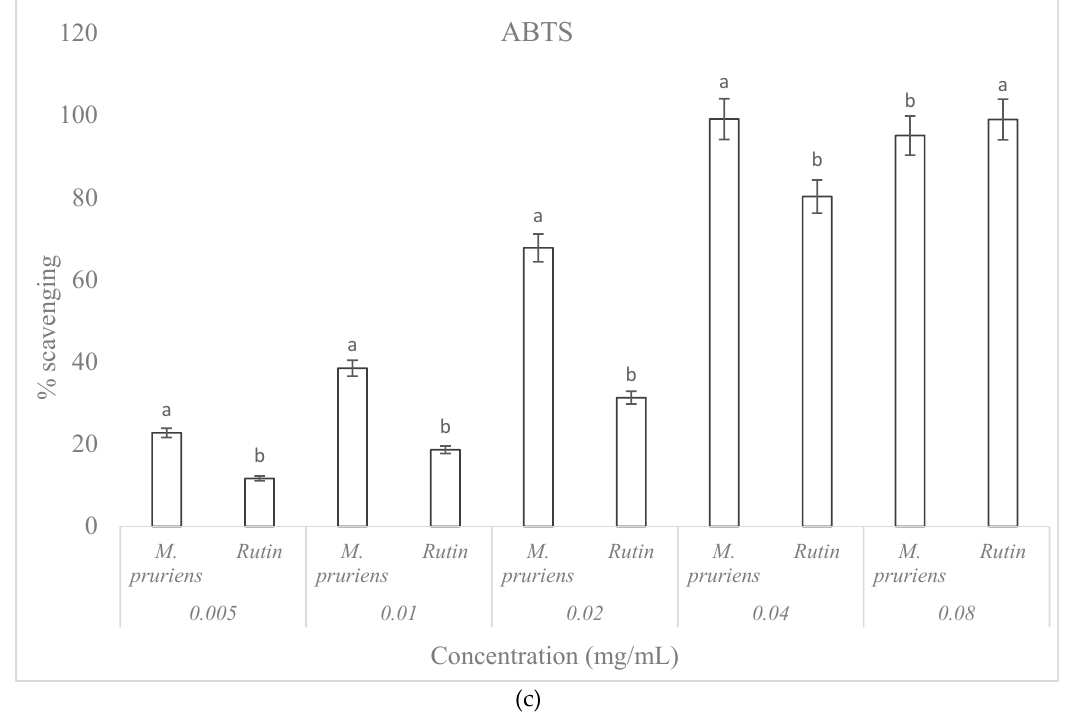
Figure 4. ( a ) Percentage 2,2-diphenyl-1-picrylhydrazyl eth (DPPH) scavenging activity of Mucuna pruriens. Mean values are compared per concentration, the values that do not share a letter are significantly different; ( b ) Ferric reducing antioxidant power of M. pruriens. Mean values are compared per concentration, the values that do not share a letter are significantly different; ( c ) Percentage 2,2 ′ -azino-bis (3-ethylbenzothiazoline-6-sulphonic acid) (ABTS) free radical scavenging capacity of M. pruriens. Mean values are compared per concentration, the values that do not share a letter are significantly different.